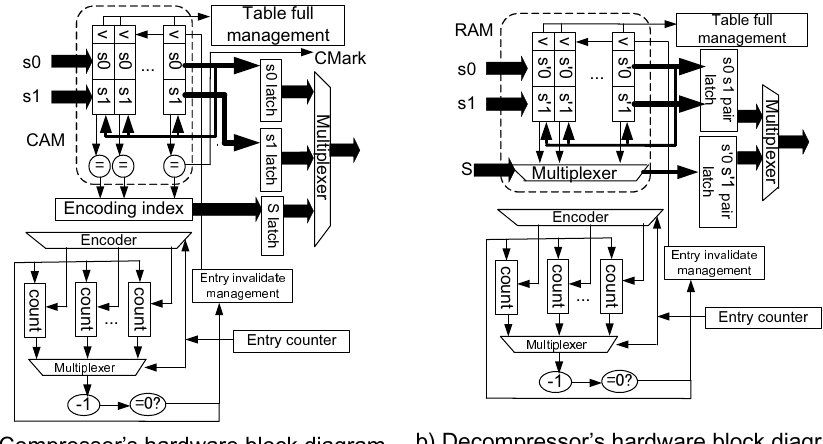
Figure 10. Implementation of LCA-DLT with the dynamic